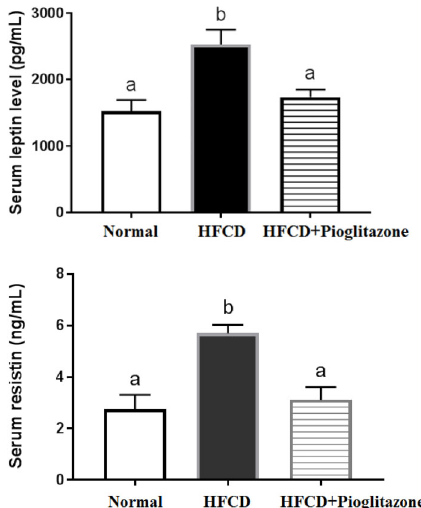
Figure 4. Changes in lipid hormones leptin and resistin of normal, high fat-carbohydrate diet (HFCD), and HFCD + pioglitazone. Data are reported as mean ± SE. Different letters indicate statis- tical a difference among groups (P o 0.05, ANOVA).